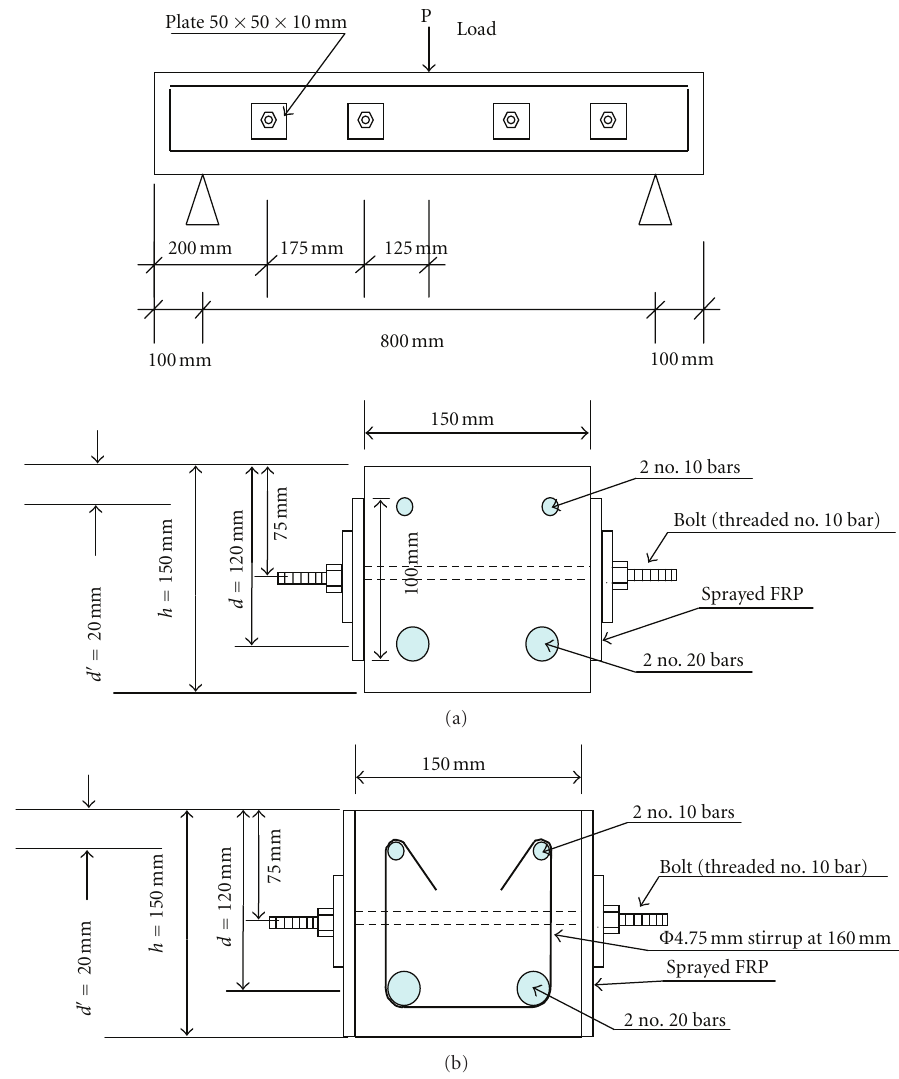
Figure 22: Cross-sectional details of RC beams; (a) B2-4B-NS-1 to B2-4B-NS-3; (b) B2-4B-S-1 to B2-4B-S-3.